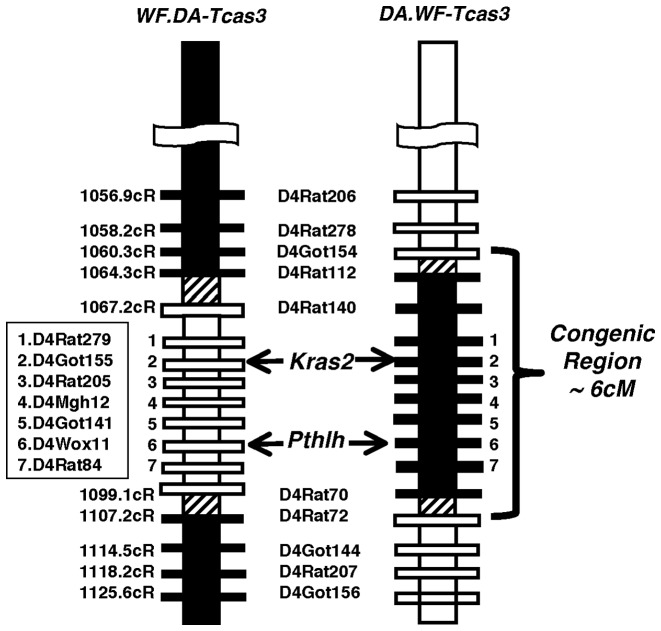
Tcas3 segment of RNO4 in the WF.DA-Tcas3 and DA.WF-Tcas3 rats. The closed column represents a WF-derived segment, the hatched column is undetermined and the open column represents a DA-derived segment. The closed bars represent the loci with the WF allele, and open bars represent loci with the DA allele. Numbers on the left indicate the map location of marker loci listed in the box (CR). RNO4, rat chromosome 4; WF, Wistar-Furth rats; DA, Dark Agouti rats.